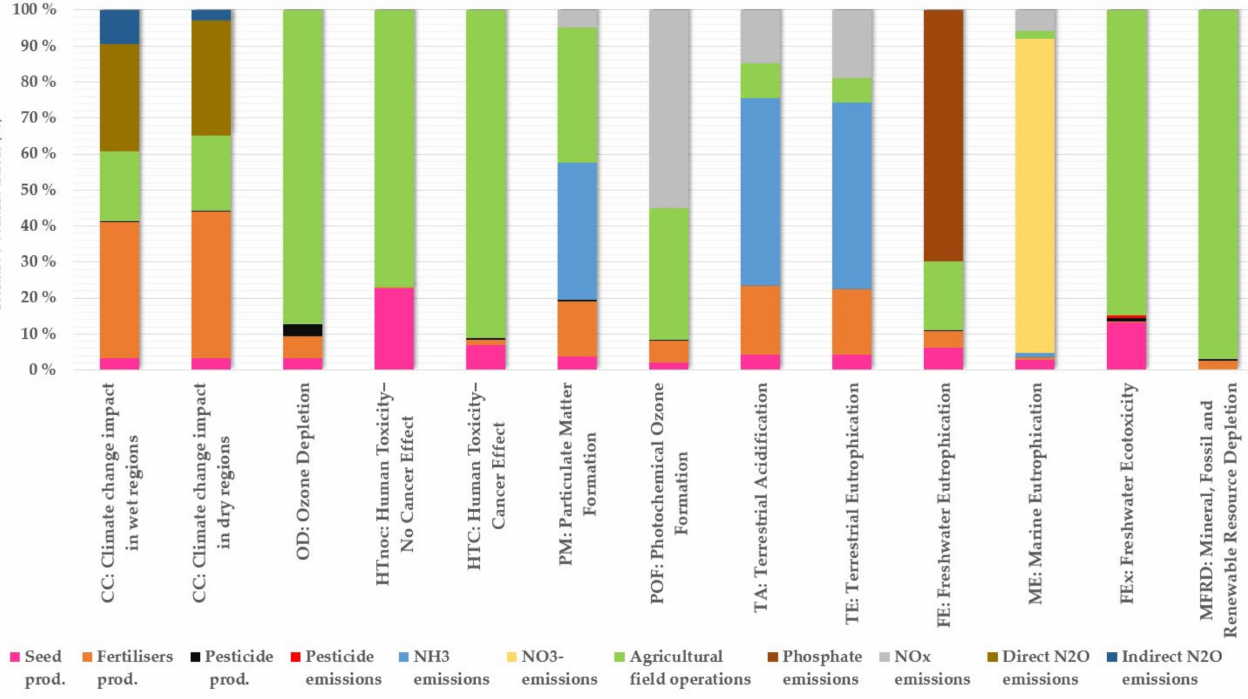
Figure 3. Relative contribution (%) of the main processes of barley grain production in Araba/ Á lava to the LCA impact categories in wet (W) and dry regions (D) under the baseline scenario (IPCC 2006 + mass-based